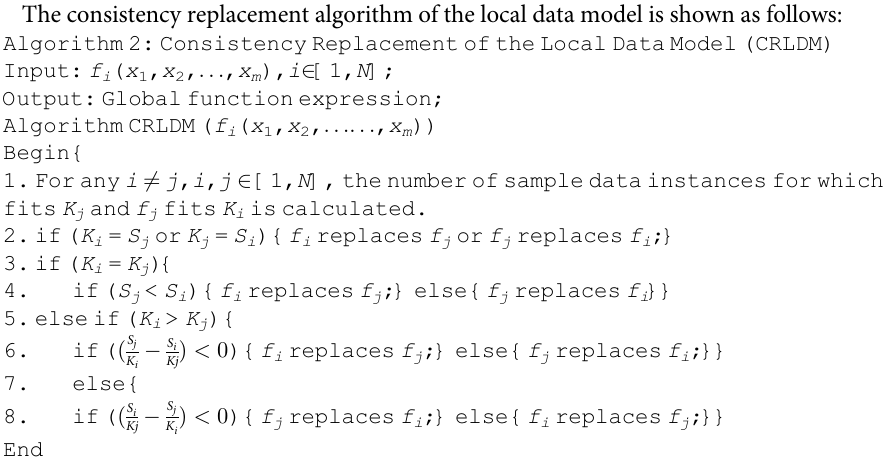
Algorithm 2: Consistency Replacement of the Local Data Model (CRLDM)